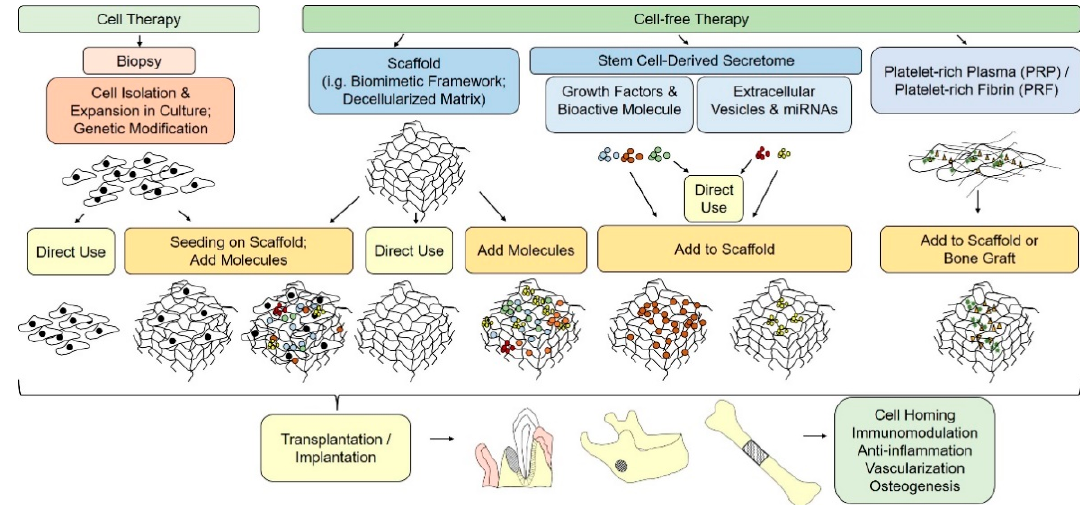
Figure 1. Schematic illustration of cell-based and cell-free paradigms for bone tissue engineering.